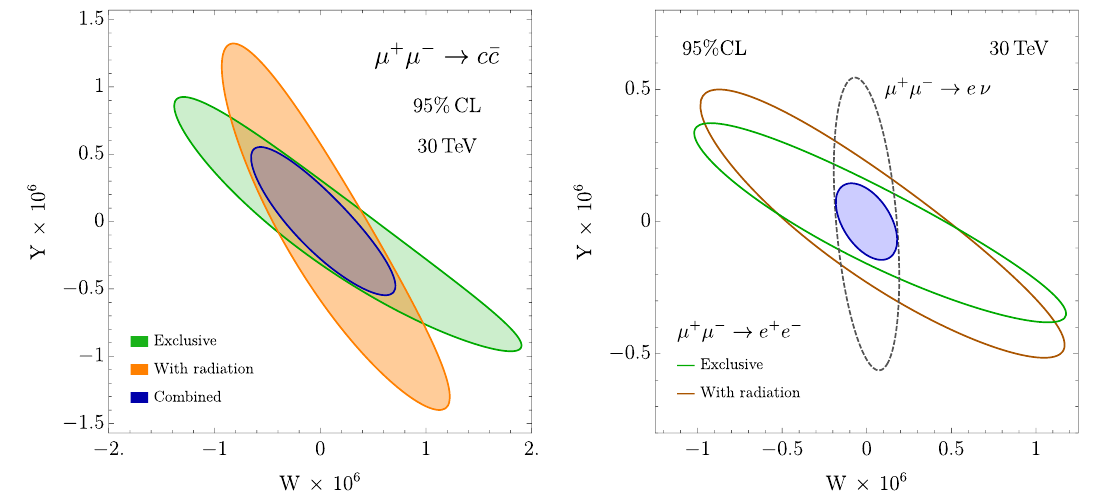
Figure 5. 95% CL sensitivities to the W and Y parameters of the 30 TeV muon collider. Exclusive and “with radiation” (i.e., semi-inclusive minus exclusive) cross-section measurements of the cc process are considered in the left panel. The right panel shows the impact of e + e − (exclusive and “with radiation”) and eν (that only exists at the semi-inclusive level) final